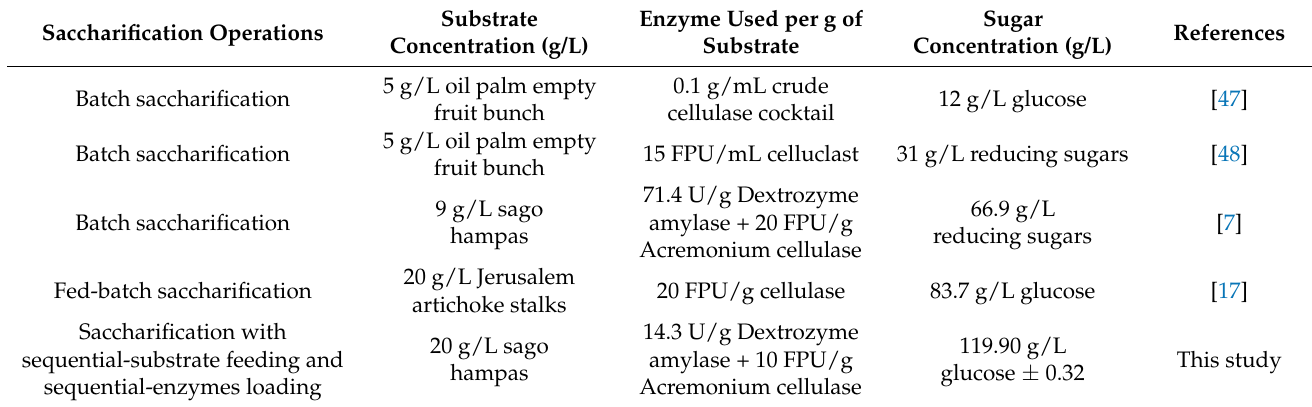
Table 5. Comparison of sugar production by various substrates, the amount of enzyme used and different saccharifi- cation